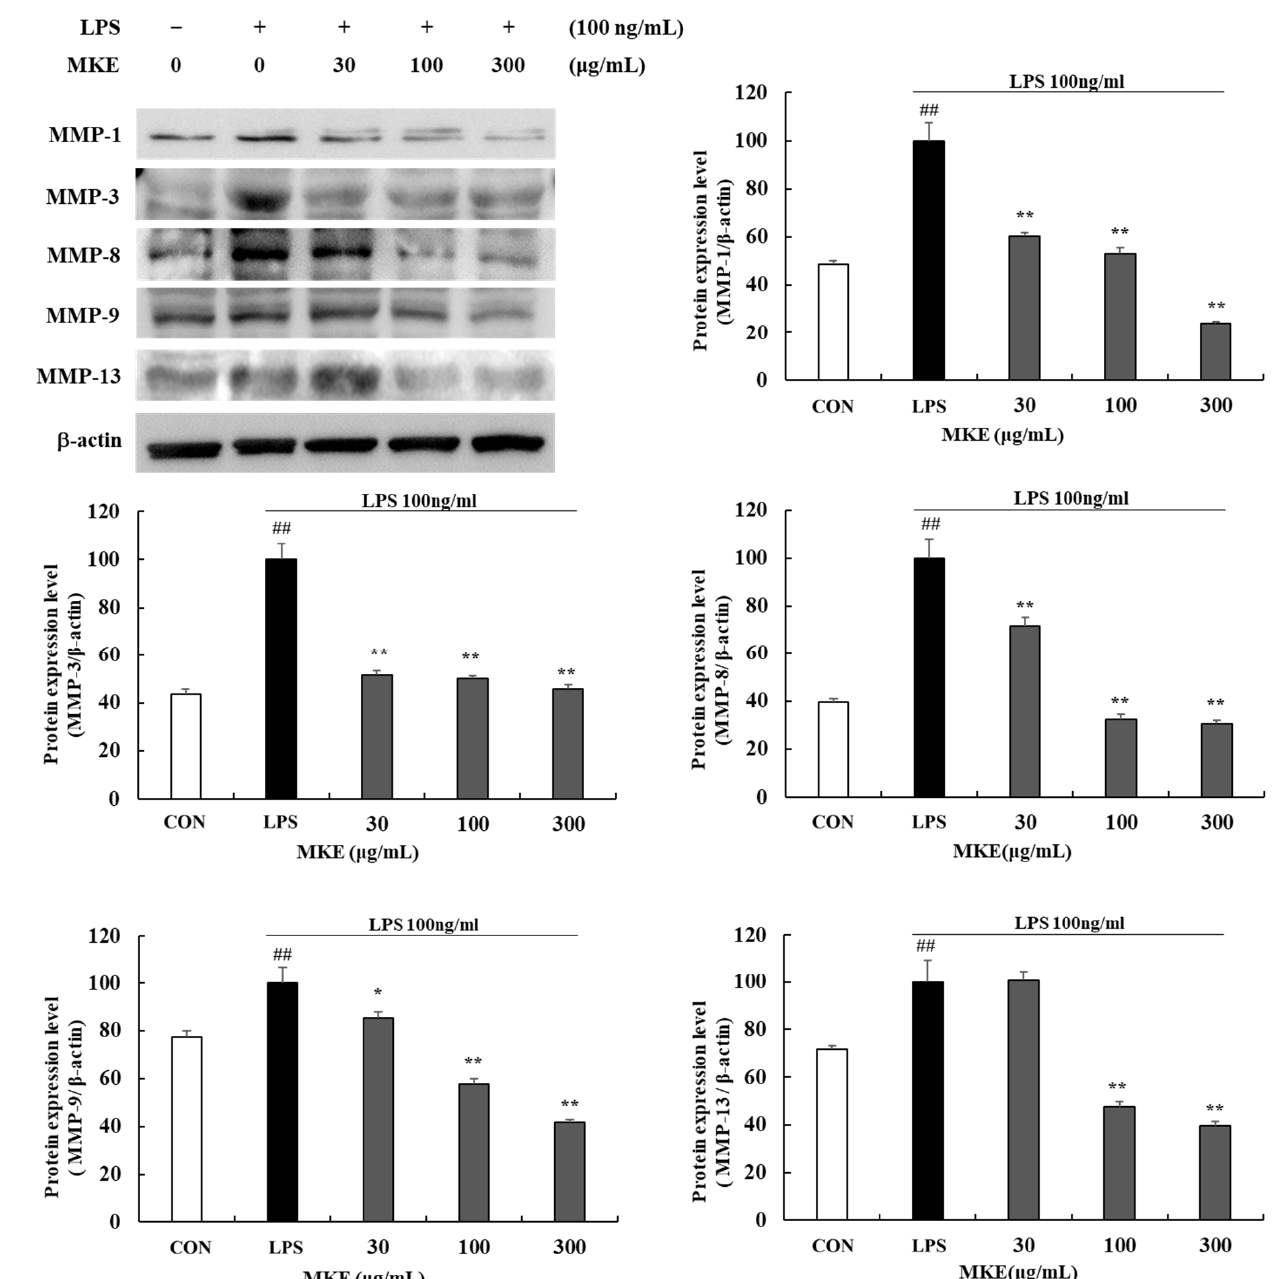
Figure 6. Effects of MKE (30, 100, and 300 μg/mL) on the production of MMPs in LPS-stimulated RAW 264.7 cells. MKE and 100 ng/mL of LPS was added except for in the vehicle control group and incubated at 37 °C for 24 h. Protein expression levels of MMP-1, MMP-3, MMP-8, MMP-9 and MMP-13 were detected by Western blot. The protein band density was measured by utilizing ImageJ software. β -actin was used as a control. Values represent means ± standard deviation. ## p < 0.01 vs. Vehicle control group; * p < 0.05 and ** p < 0.01 vs. LPS-activated control group.